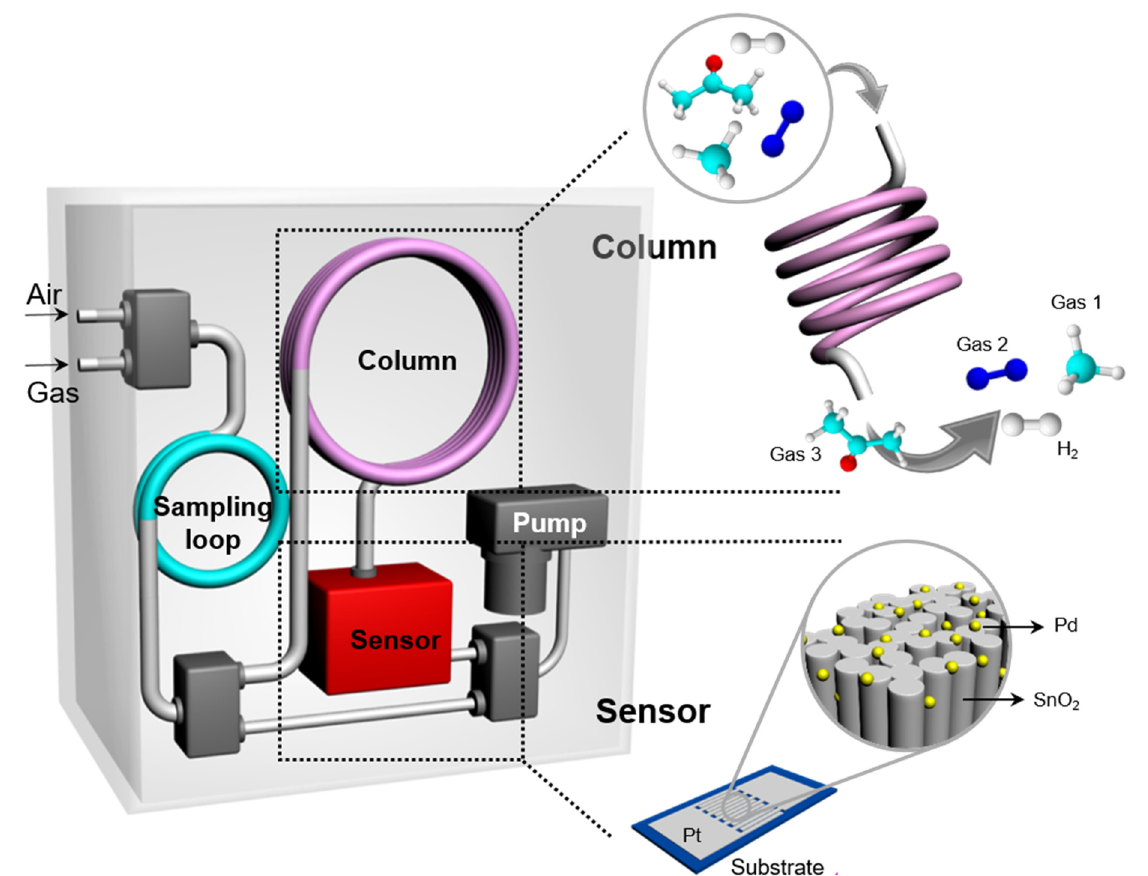
Figure 1. Schematic illustration of a hydrogen analyzer using a miniaturized gas chromatography (mini-GC).